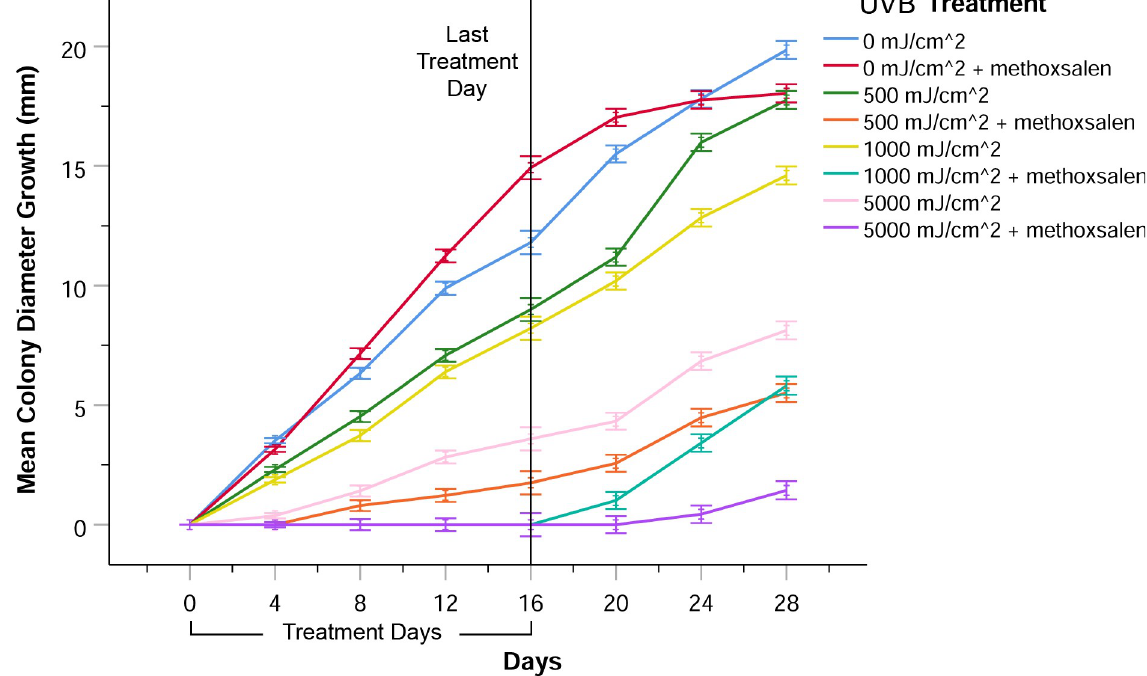
Fig 4. Pseudogymnoascus destructans colony growth with repeated methoxsalen and UVB exposure. Colonies were exposed to methoxsalen and irradiated with UVB (312 nm) once every four days, for a total of five treatments. Control colonies received no UVB exposure or methoxsalen, or were singly exposed to methoxsalen. Colonies receiving UVB alone demonstrated growth inhibition. Ultraviolet B exposure inhibited growth of P . destructans colonies infused with methoxsalen in a UV dose-dependent manner. Results were derived from eight biological replicates. Error bars represent one standard error of the